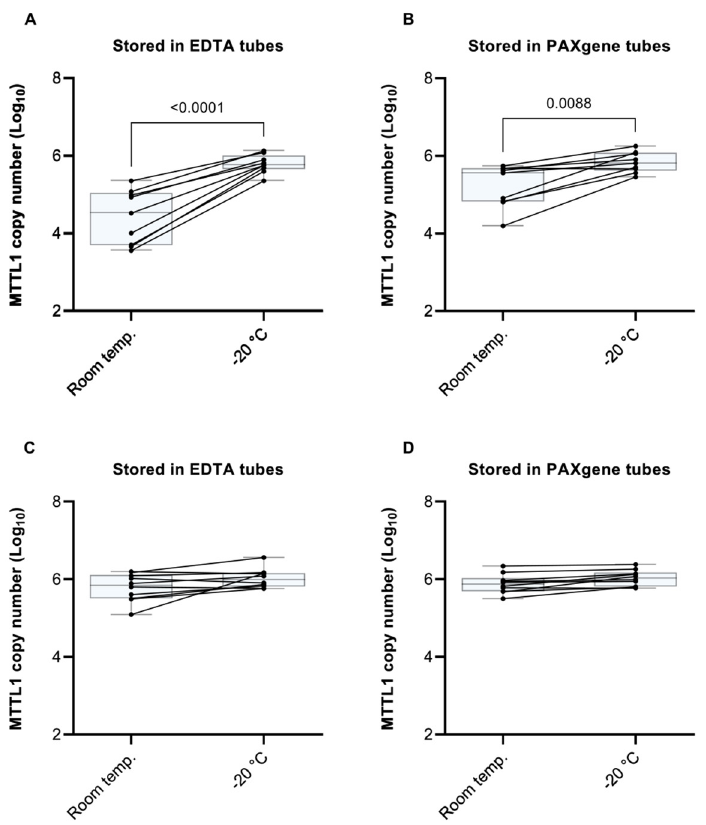
Figure 2. The effect of storage temperature on mitochondrial (mtDNA) levels. Top part ( A , B ): Com- parison of mtDNA copy number present in whole blood samples of healthy subjects stored at room temperature (RT) vs. − 20 ◦ C prior to processing in ( A ) EDTA tubes and ( B ) PAXgene tubes. Bottom part ( C , D ): Comparison of mtDNA copy number present in whole blood samples of pancreatic cancer patients stored at room temperature (RT) vs. − 20 ◦ C prior to processing in ( C ) EDTA tubes and ( D ) PAXgene tubes. Part 2 ( C , D ): MtDNA was obtained by semi-automated isolation using the Max- well RSC Instrument and quantified by an MTTL1 qPCR assay. Ten subjects were recruited in each cohort. Significant outliers were identified and omitted using Grubb’s test (Alpha = 0.05). The fold- change in the copy number of MTTL1 for each patient is summarized in Supplementary Table S1.